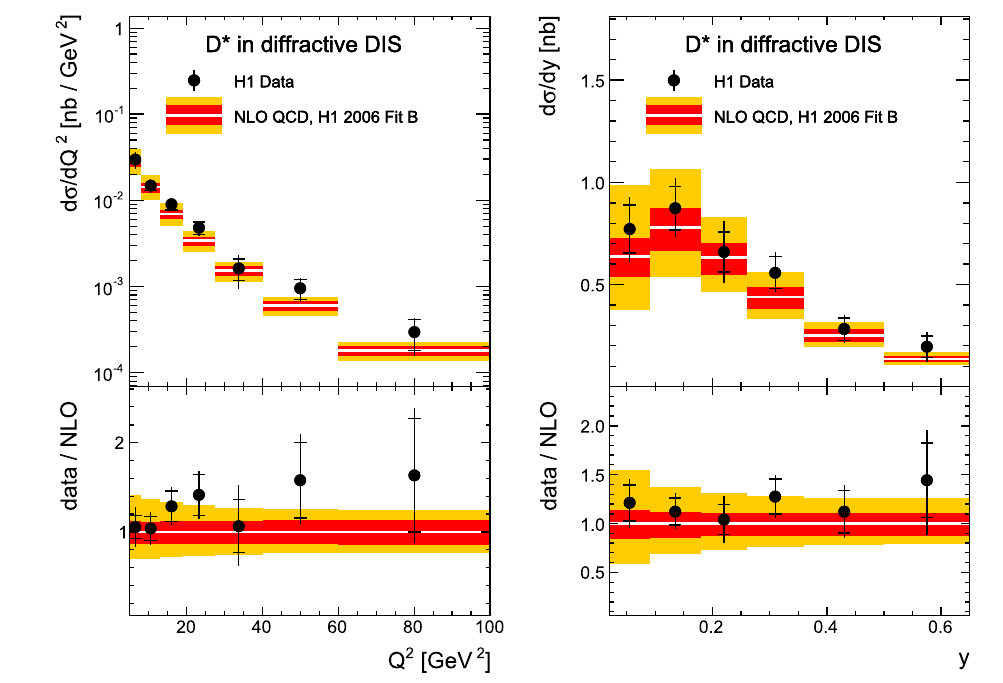
line inside the coloured bands . The inner band represents the DPDF and fragmentation uncertainties added in quadrature. The outer band represents DPDF, fragmentation, charm mass, factorisation and renor- malisation scale uncertainties added in